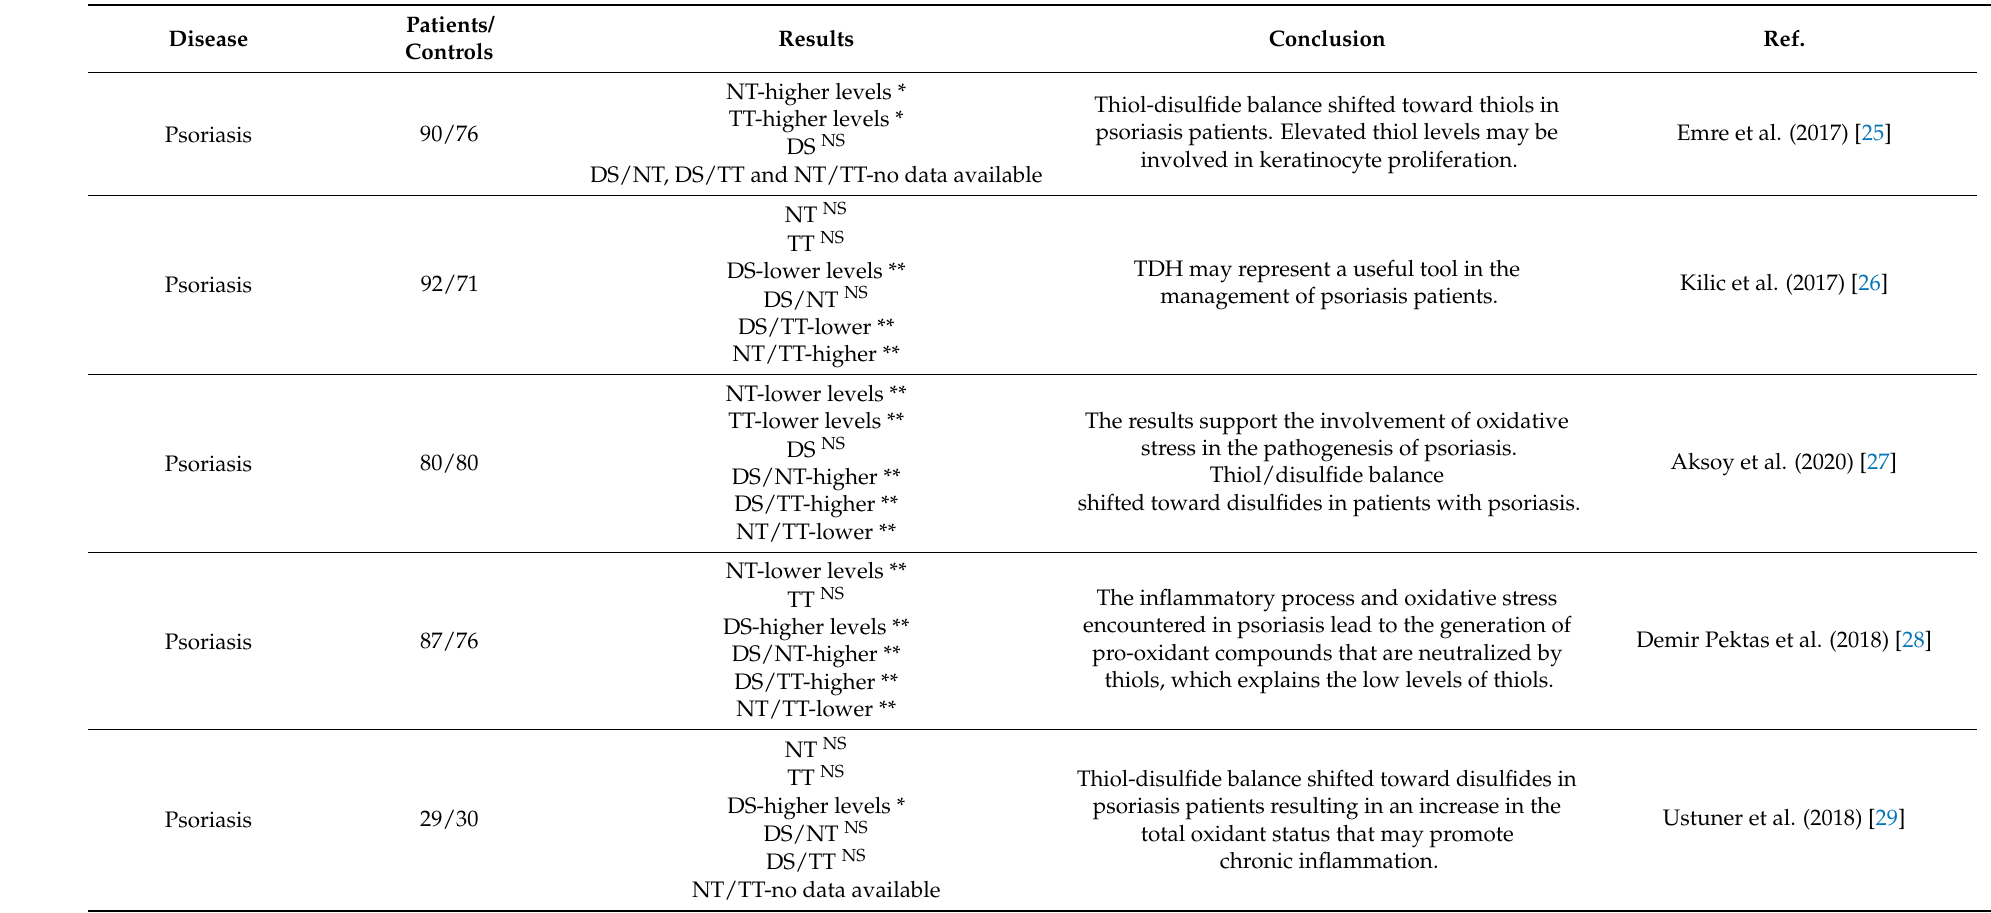
Table 1. Data on TDH parameters in inflammatory skin